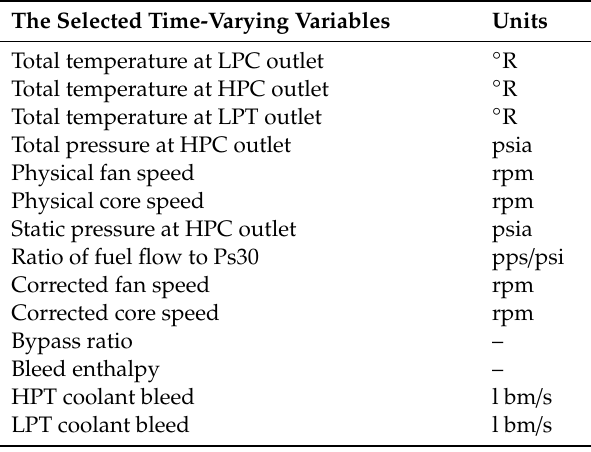
Table 3. The selected time-varying